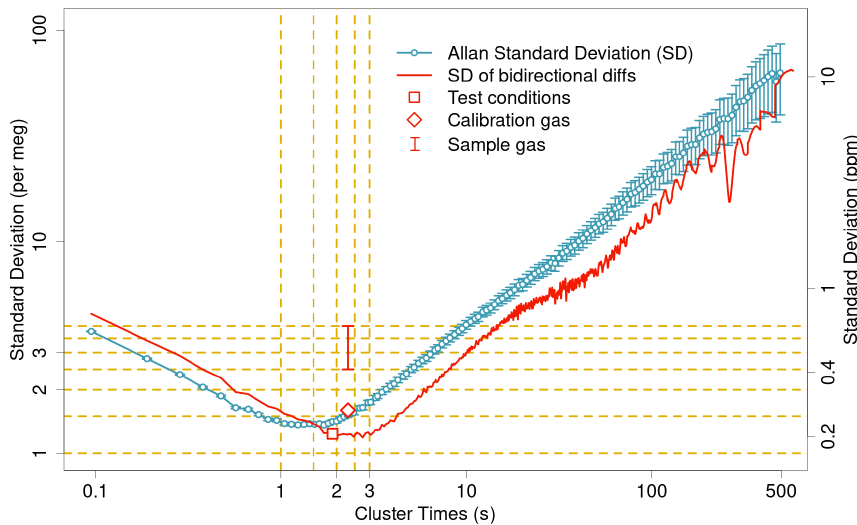
Figure 4. AO2 signal noise characteristics from a laboratory test running a single calibration gas without changeover valve switching for 40min on a log–log plot. The two-sample Allan standard deviation and errors are as calculated by the allanvar package in R . The standard deviation of the three-sample bidirectional differences are calculated as in AO2 processing for hypothetical valve switching intervals. During this test the instrument was able to make 20 analog to digital conversions in 1.9s rather than 2.3s as in flight, owing to sampling fewer diagnostic signals. Symbols show the results of applying the AO2 processing on 20-sample intervals from this lab test, as well as a more typical value for calibration gas during smooth flight conditions and a typical range of values for sample gas in flight during smooth to moderate turbulent conditions. The increase in noise for calibration gas in flight is related to slight motion effects and trends during a calibration cycle. The increase in noise for sample air in smooth flight is likely caused by thermal gradients in the cryotrap. The left y axis shows values in per meg δ (O 2 / N 2 ) and the right y axis shows ppm in O 2 mole